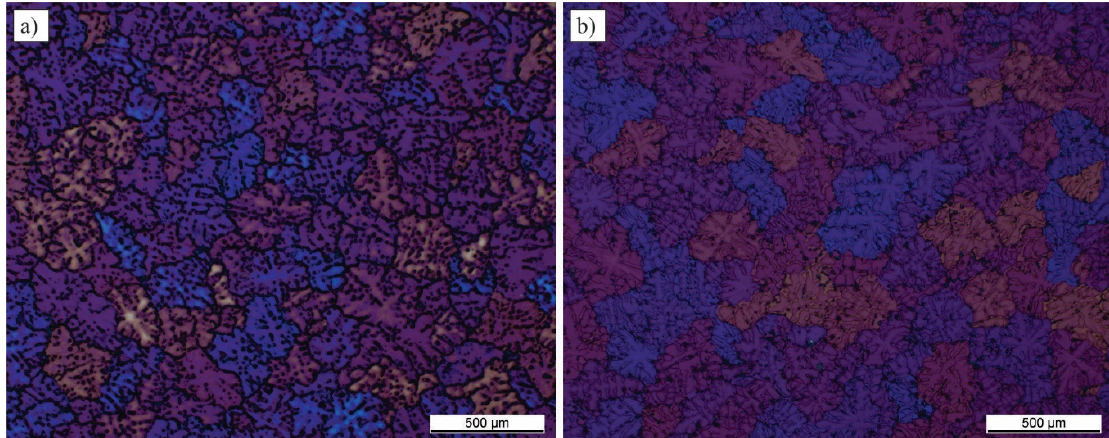
Figure 3. The light micrographs of the alloy AA 6086 in ( a ) the as-cast condition and ( b ) after homogenization treatment. SEM-micrographs (Figure 4) revealed the presence of other phases in the interdendritic regions. The EDS-analysis showed that α -Al contained from 96.1 to 97.7 wt.% Al. At the centre of α -Al, the contents of Si and Cr were higher than in the interdendritic regions, the contents of Mg and Mn was less at the centre, while the contents of Cu and Zr were almost the same. The distribution of elements was uniform after homogenization. The contents of Si and Cr in the α -Al increased, the contents of Mg and Mn decreased,